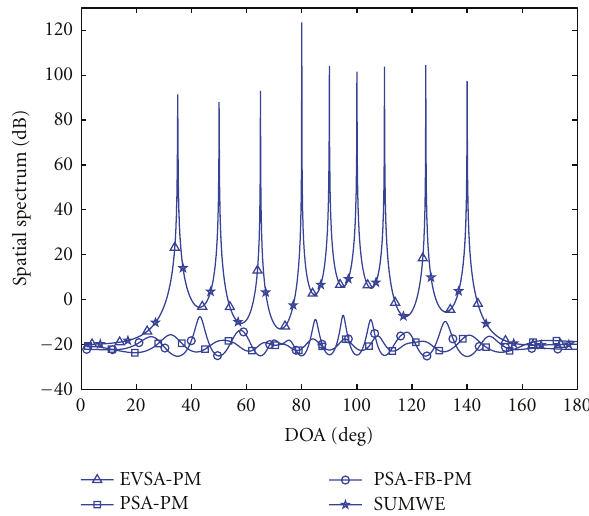
Figure 6: Spatial spectrum of EVSA-PM, PSA-PM, PSA-FB-PM, and SUMWE for nine coherent